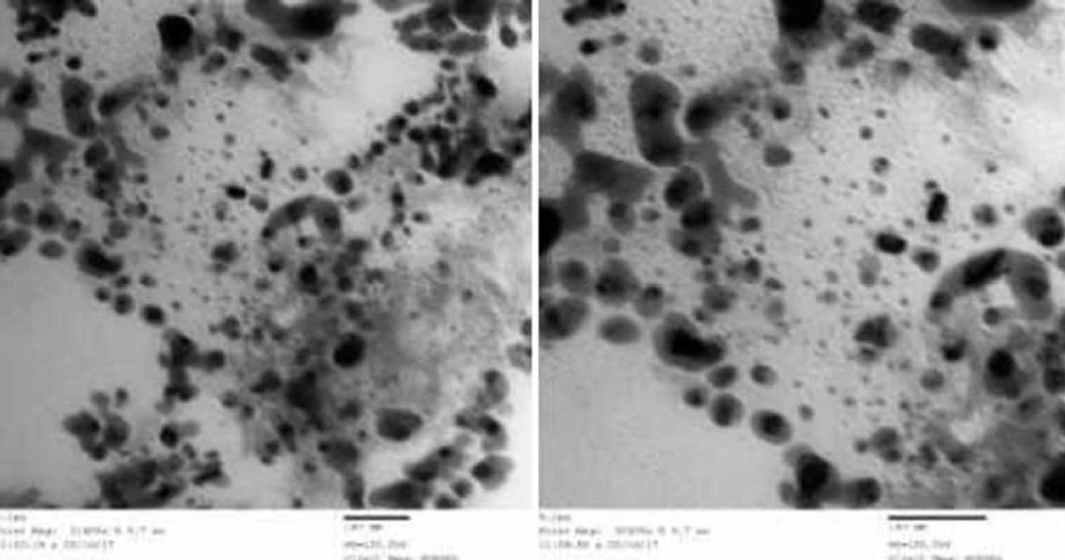
Figure 1. Electron micrograph of thymoquinone-PLGA nanoparticles suspension showing confirmation of size and shape. The designed nanoparticles appeared around 20 nm size and spherical shape. Scale bar = 50 nm (HV = 120.0 KV, Direct Mag: 40,000